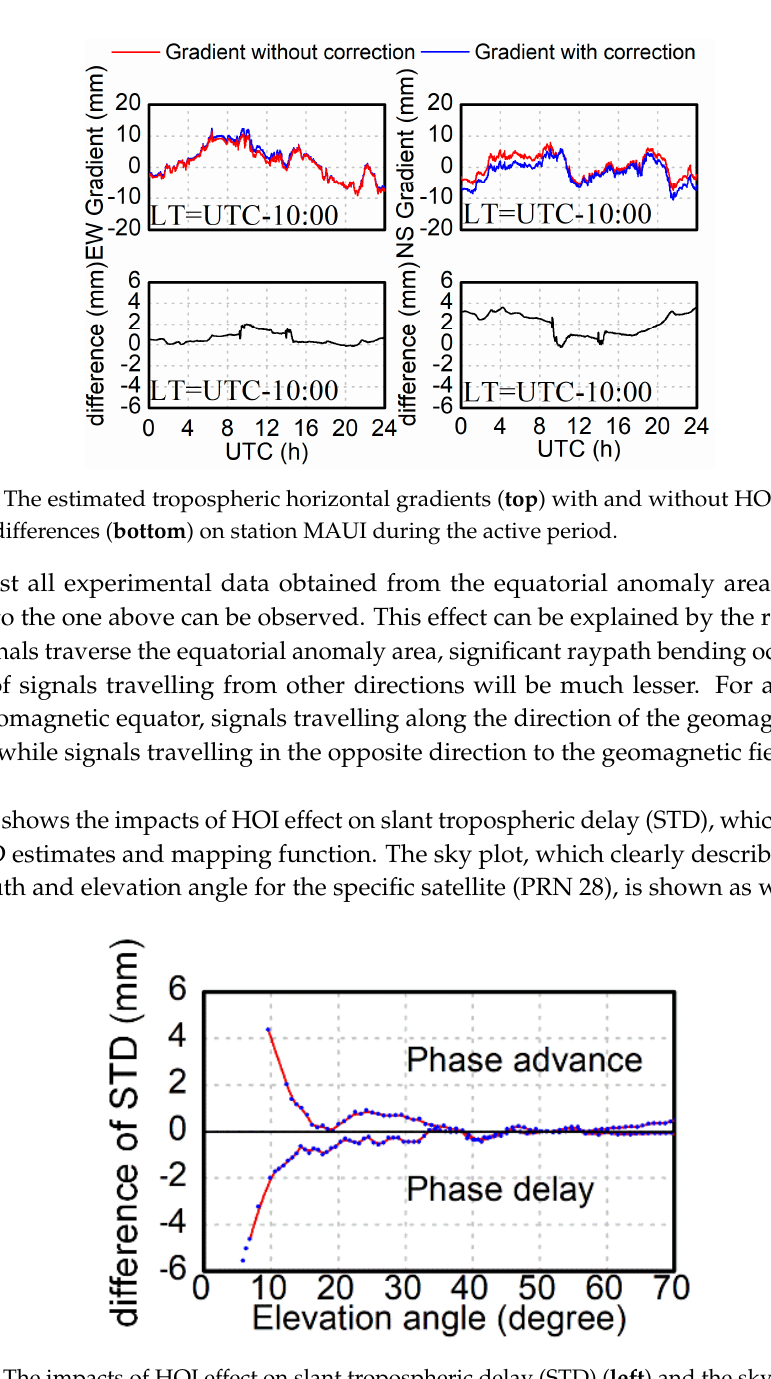
Figure 11. The estimated tropospheric horizontal gradients ( top ) with and without HOI corrections and their differences ( bottom ) on station MAUI during the quiet period.